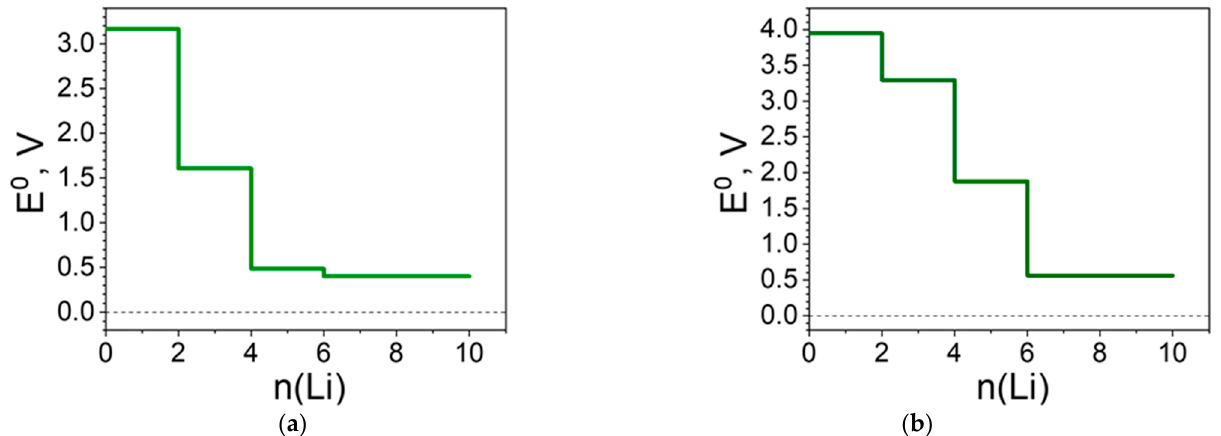
Figure 14. Redox potential profile (E 0 vs. Li + /Li 0 ) of: ( a ) [Ni(II)L3] n and ( b ) [Ni(IV)L3] n upon lithiation.